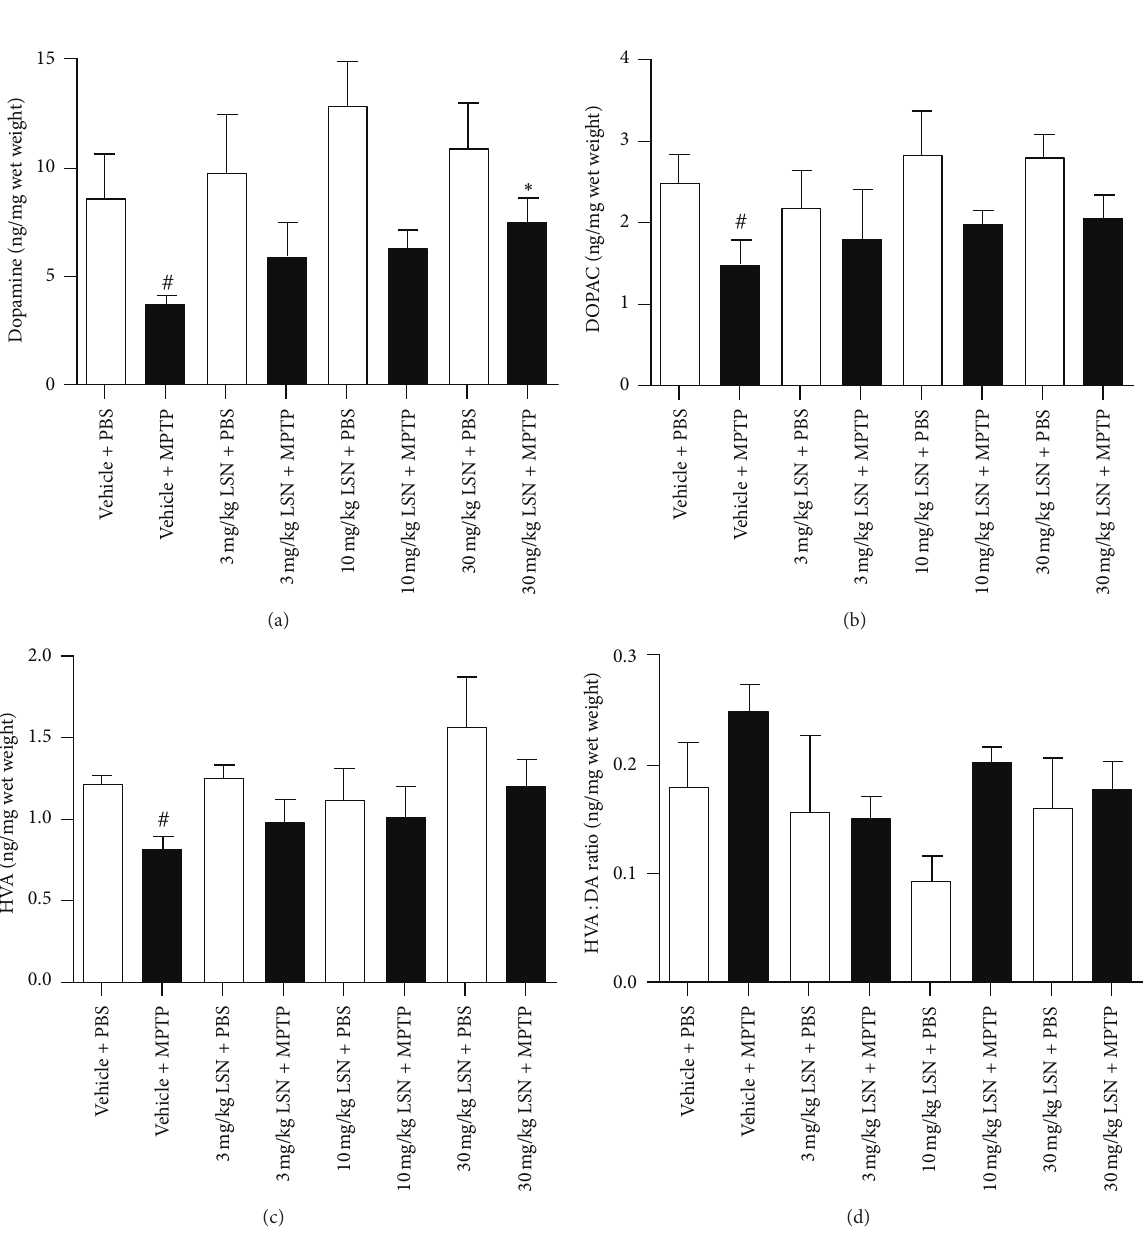
treated with MPTP or PBS and vehicle or 30 mg/kg of